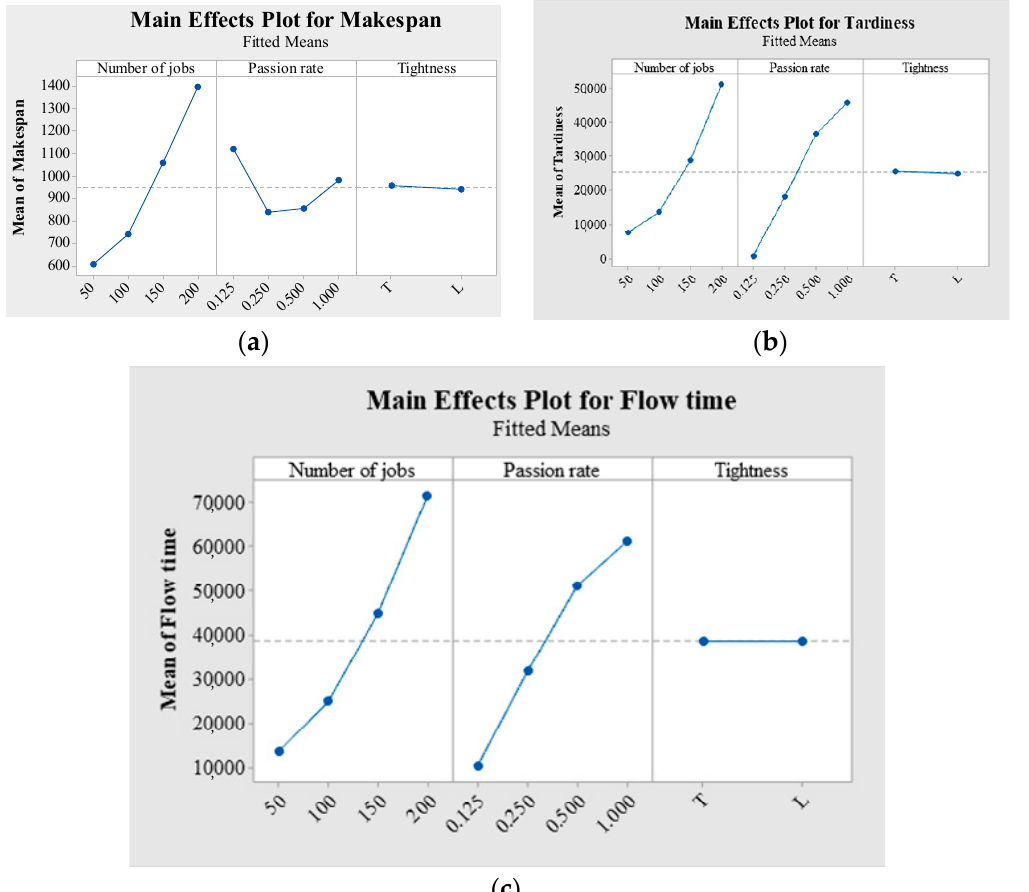
Figure 9. Factorial plot for different objective functions. ( a ) Main effects Plot for Makespan. ( b ) Main effects Plot for Tardiness. ( c ) Main effects Plot for Flow time. Table 7. ANOVA of different objective